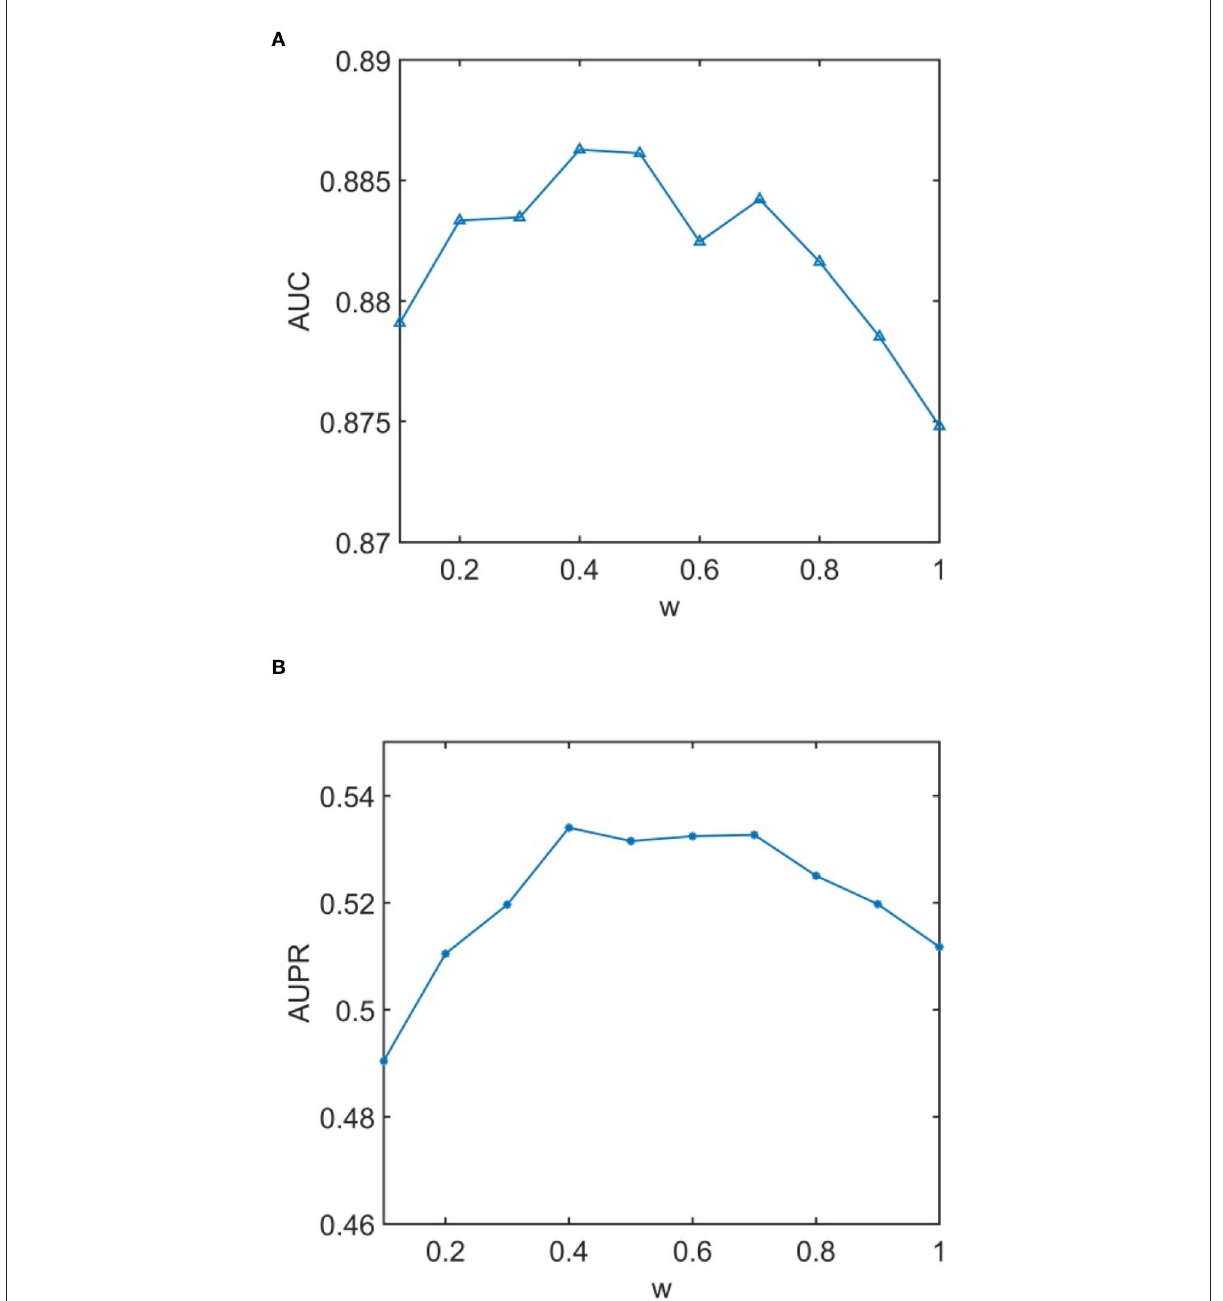
FIGURE6 Analytical plots of AUC and AUPR for w in the label propagation (LP) algorithm. (A) Analytical plots of AUC for w . (B) Analytical plots of AUPR for w